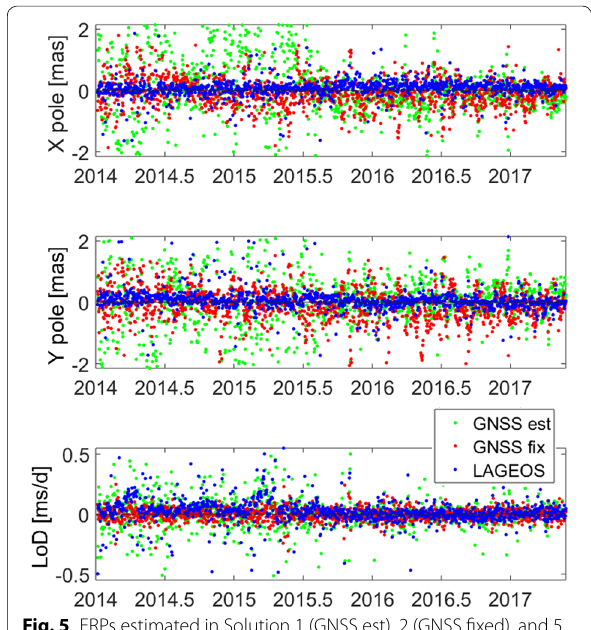
Fig. 5 ERPs estimated in Solution 1 (GNSS est), 2 (GNSS fixed), and 5 (LAGEOS) compared to the IERS-14-C04